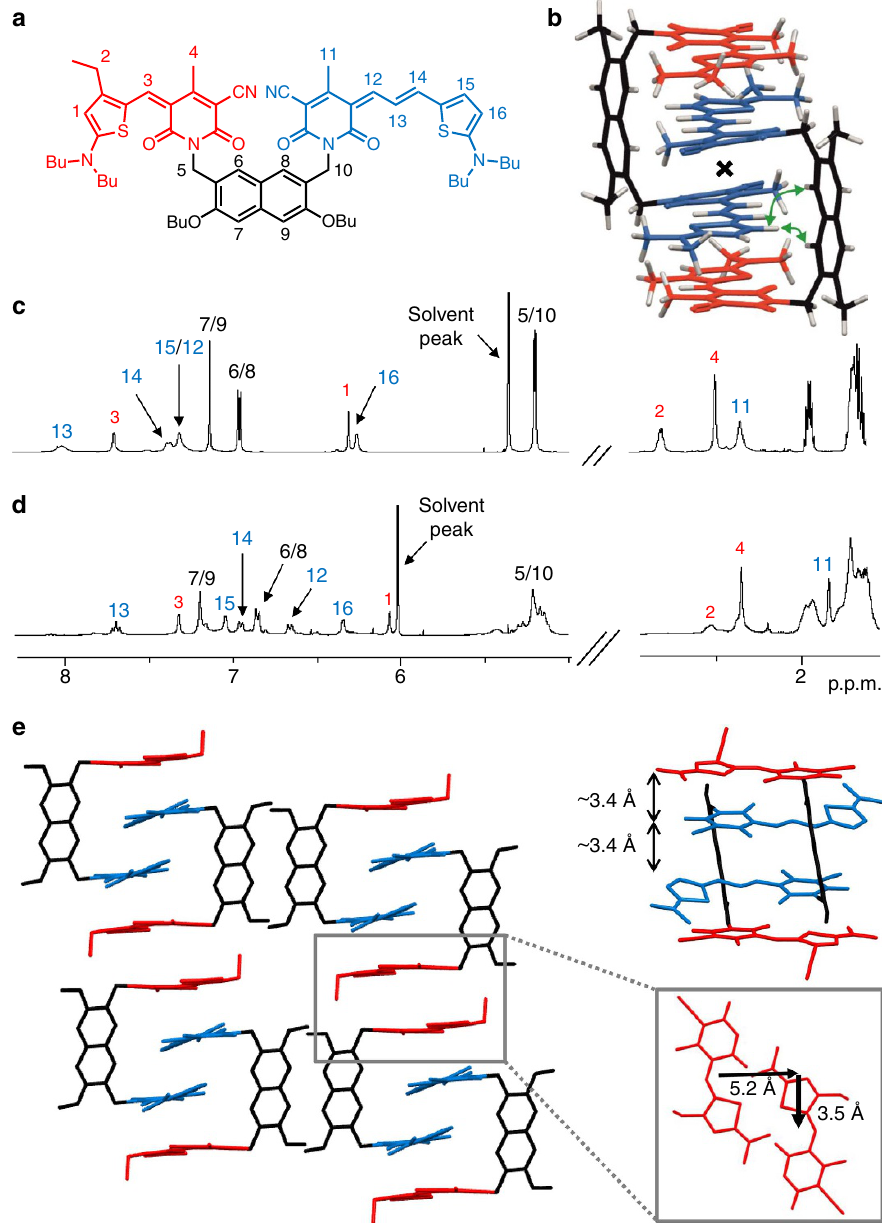
Figure 4 | NMR studies and single-crystal X-ray analysis of bis(merocyanine) 2. ( a ) Chemical structure of 2 with the significant protons numbered. ( b ) Geometry-optimized structure (B97D3/def2-SVP, alkyl chains were replaced by methyl groups) of dimer aggregate. The inversion center of the dimer is indicated with a cross, and the green curved arrows indicate the close proximity of chromophore and backbone protons in the dimer. ( c ) Relevant sections of 1 H NMR (600MHz) spectrum of 2 monomer in CD 2 Cl 2 ( c ¼ 5 (cid:2) 10 (cid:3) 3 M) at 295K. ( d ) Spectrum of aggregate in a 1:1 mixture of 1,1,2,2- tetrachloroethane-d 2 /tetrachloromethane ( c ¼ 8 (cid:2) 10 (cid:3) 3 M) at 253K with the assignment of significant proton signals. ( e ) Molecular packing of 2 in the solid state (side view) with enlargement of the dimer structure motif (front view). Solvent molecules and hydrogen atoms are omitted for clarity and butyl chains were replaced by methyl groups. A section of the crystal structure (top view) of 2 is shown ( e , right) illustrating the lateral and transversal shift of two chromophores of next-neighboured quadruple dye